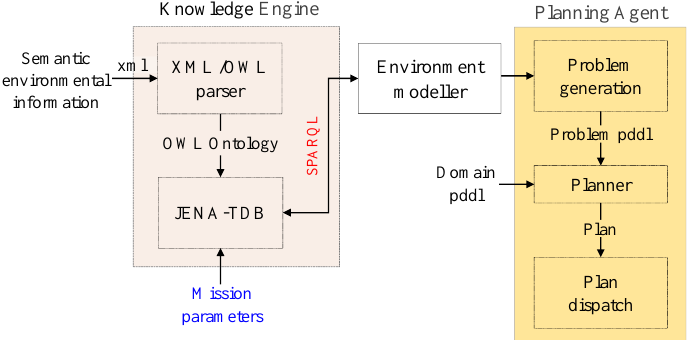
Figure 4. Detailed architecture of the knowledge engine, environment modeler, and PDDL